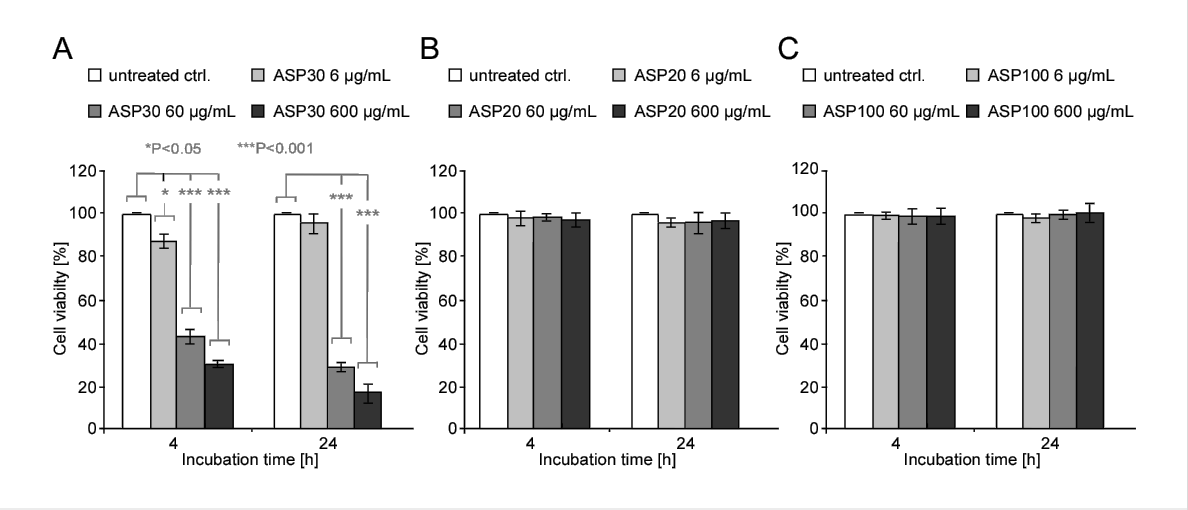
Figure 3: Impact of ASP30 on the cellular metabolic activity. (A/B/C) Caco-2 cells were incubated with the indicated concentrations of ASP30 (A), ASP20 (B) and ASP100 (C) in serum-free DMEM and analyzed after 4 or 24 h by using the MTT assay. Data are depicted as percentage compared to untreated control cells, which was set to 100% vitality. Results are shown as means ± SD ( n = 3). * P < 0.05, ** P < 0.01 and *** P <